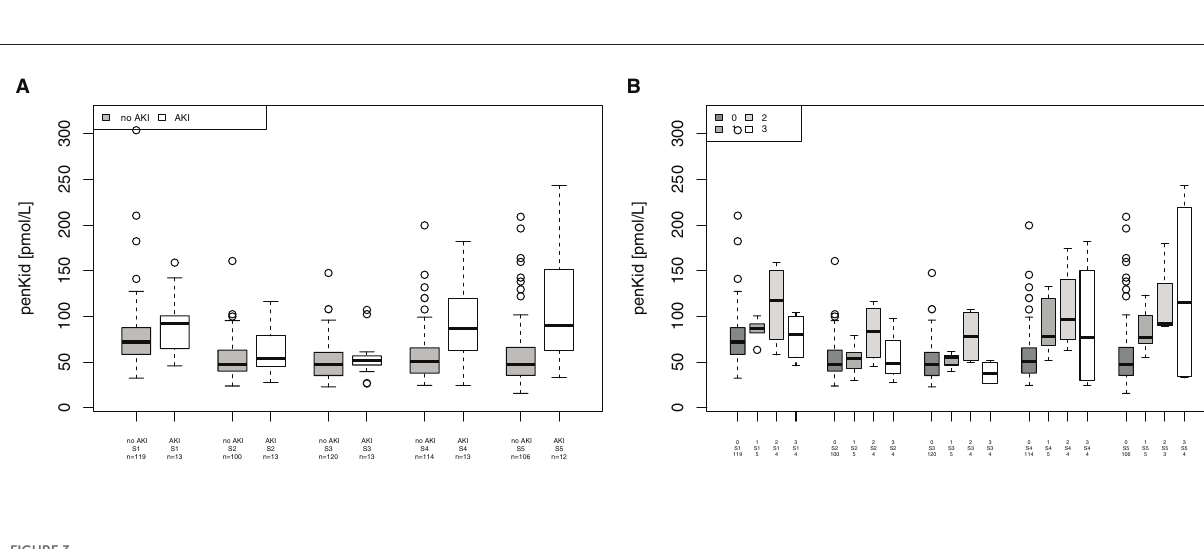
FIGURE3 Association of proenkephalin A (penKid) with acute kidney injury (AKI). (A) Comparison of penKid levels in patients with/without AKI. (B) penKid levels in patients by Acute Kidney Injury Network (AKIN) class. n, number of patients; S1, prior to surgery; S2, intraoperatively at the end of cardiopulmonary bypass; S3, at ICU admission; S4, 24h after surgery; and S5, 48h after